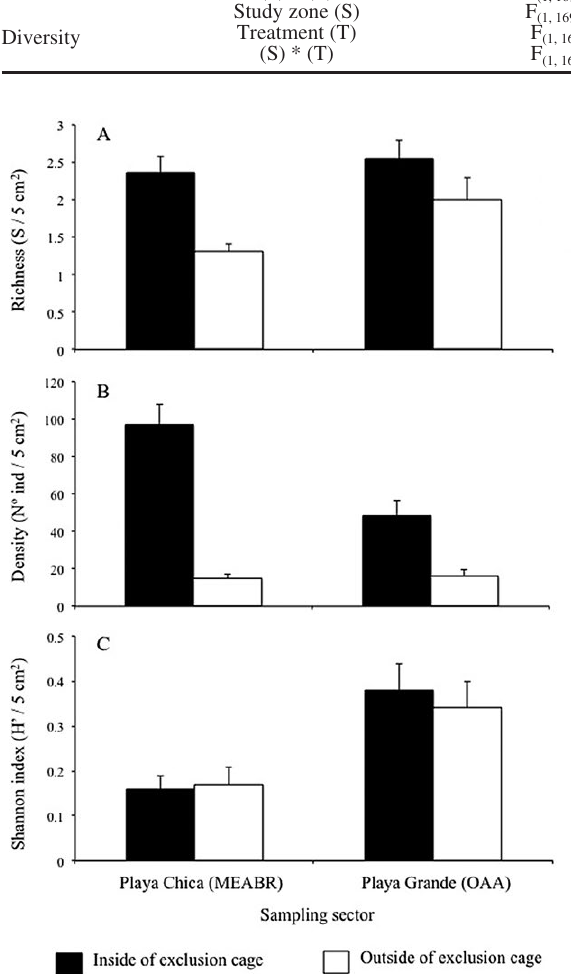
Fig. 1. – Invertebrate community descriptors “inside” and “outside” exclusion cages in the MEABR and the OAA. (A) Species richness, (B) density and (C) invertebrate diversity. Bars indicate SEM (± 1).